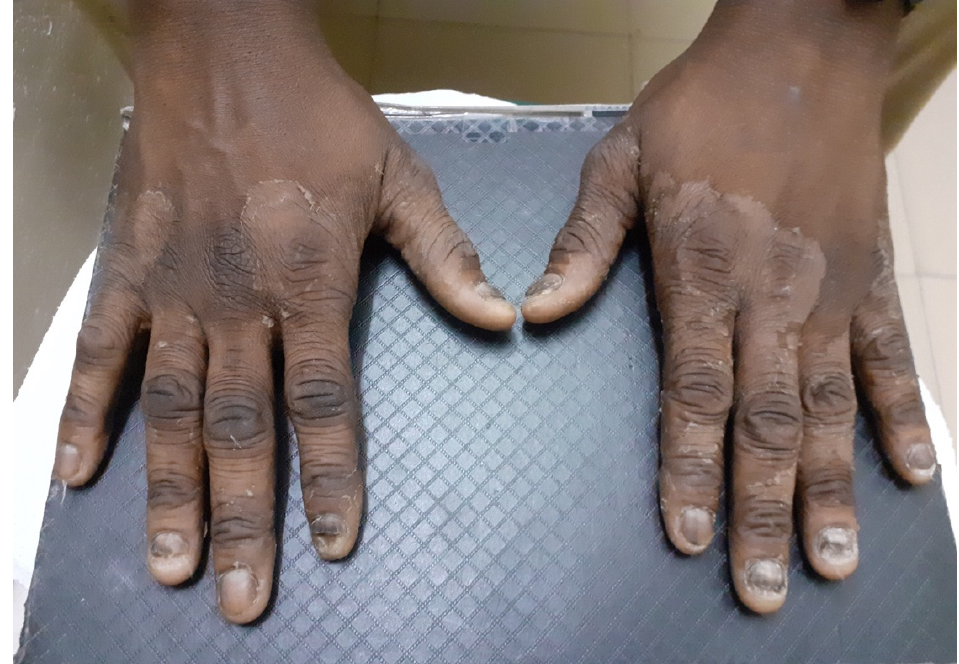
Figure 1. Dermatophytosis of the hands (tinea manuum) and fingernails (tinea unguis).